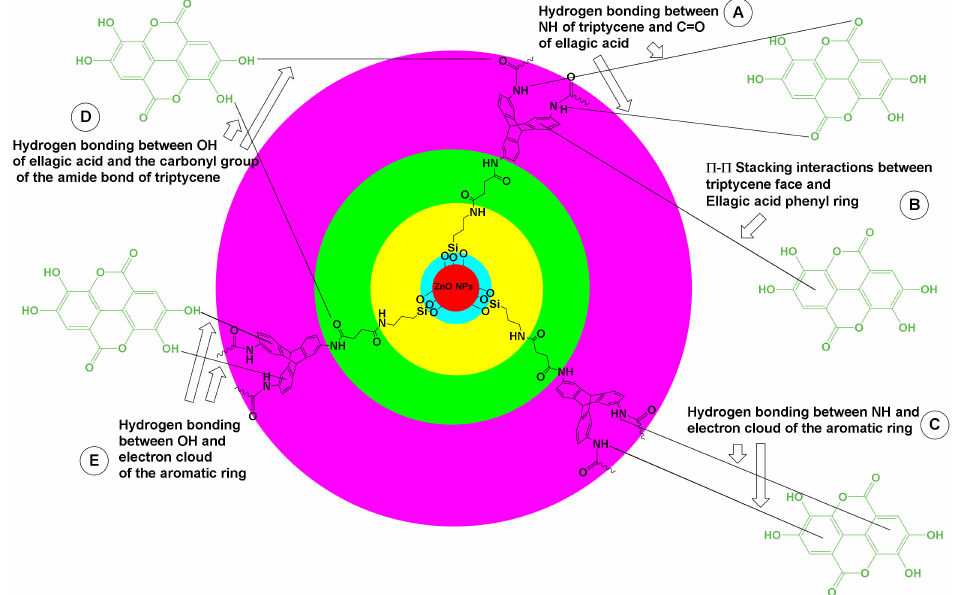
Figure 1. The possible link between the hybrid inorganic–organic nanoparticles and ELG molecules to form the nanoformulation. ( A ) Proposed hydrogen bonding between NH and C=O. ( B ) π – π stacking. ( C ) Hydrogen bonding between the NH and electron clouds. ( D ) Hydrogen bonding between OH and the carbonyl group. ( E ) Hydrogen bonding between OH and the electron